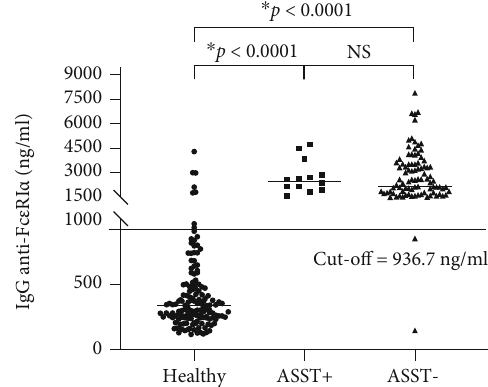
Figure 2: Levels of hIgG anti-Fc ε RI α in sera from the second cohort of healthy and CSU volunteers. Scatter plot represents levels of human IgG against anti-Fc ε R1 α in healthy ( n = 150 ), ASST positive ( n = 14 ), and ASST negative ( n = 102 ) ( mean ± SEM ). ∗ A p value of less than 0.05 was statistically signi fi cant. The cut-o ff line was set at